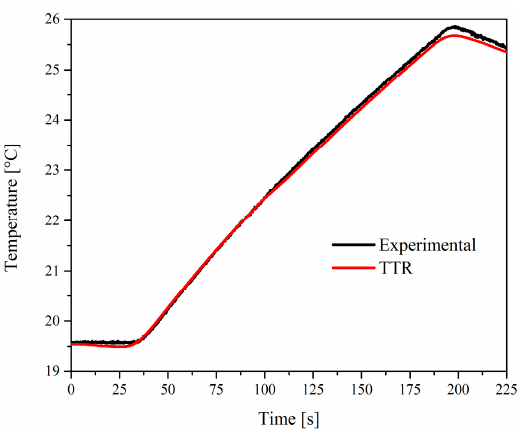
Figure 12. Comparison between the experimental and numerical temperatures for r = 60 with TTR.